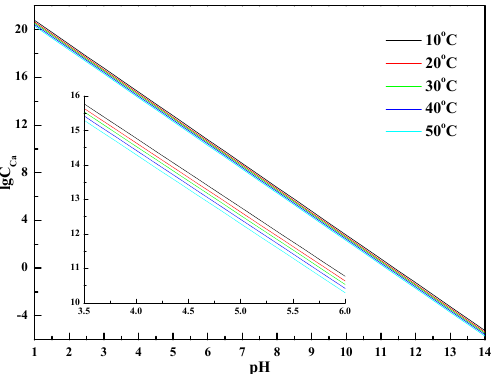
Figure 3. pH-lg C Ca diagram of Ca 2+ in solution at different temperatures.